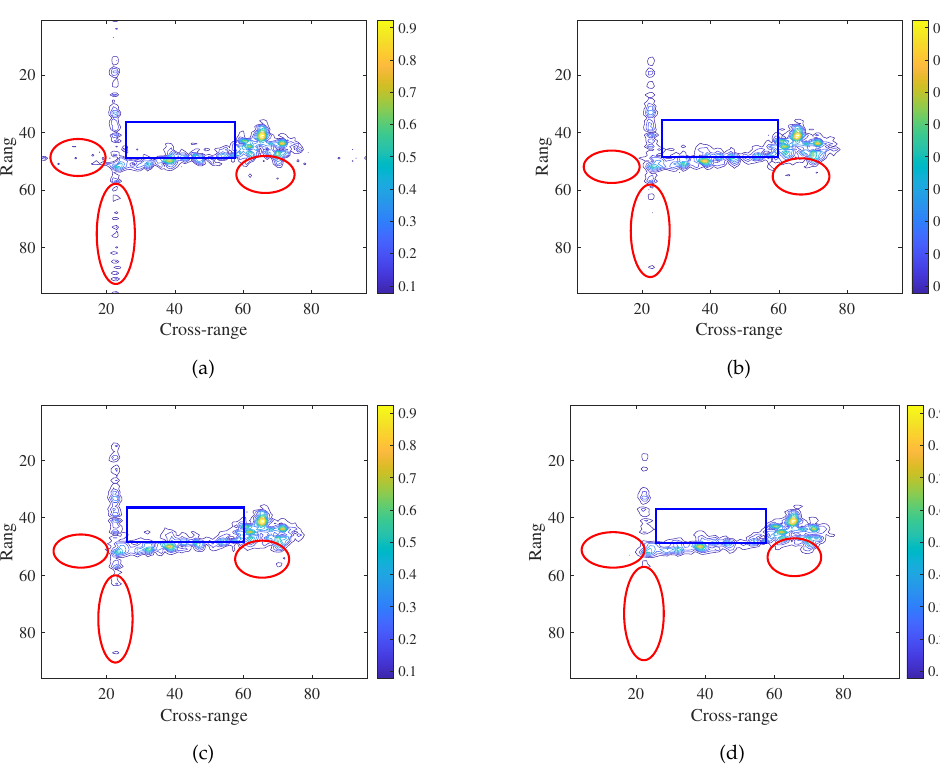
Figure 9. The target images of ship data yielded by ( a ) GKF imaging method, ( b ) ONDL imaging method, ( c ) OFDL imaging method as well as ( d ) the GDL imaging method using 50%